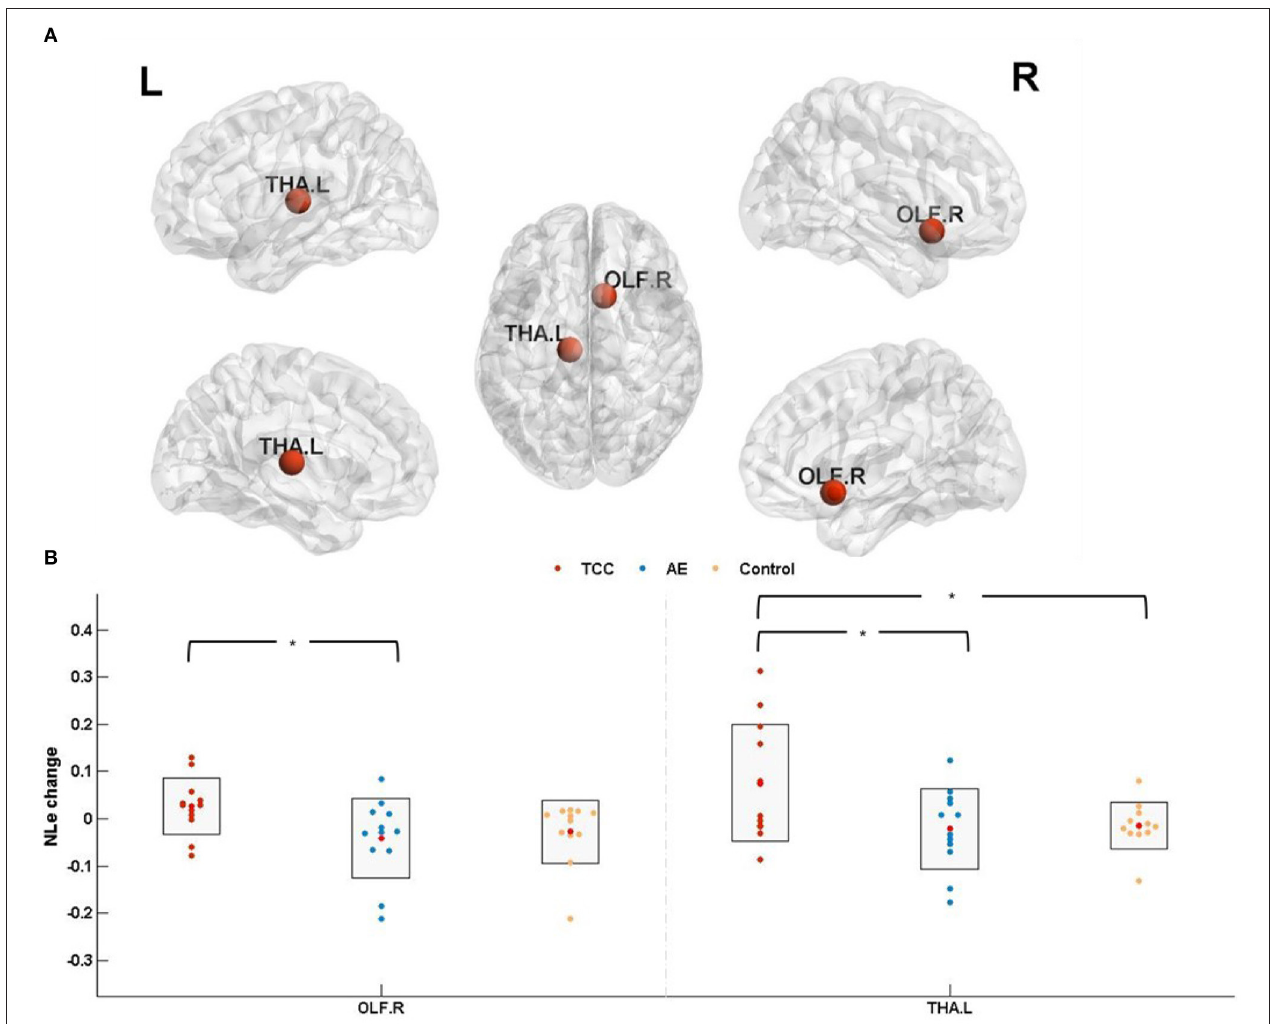
FIGURE 5 | Nodal local efficiency results. (A) The results of nodal efficiency changes are presented on axial slices of the gray matter templates (MNI); Bonferroni-corrected. (B) The results of post-hoc statistical analysis of NL e changes (post minus pre). * p < 0.05; ** p < 0.01. OLF.R, right olfactory cortex; THA.L, left thalamus; NL e , nodal local efficiency.